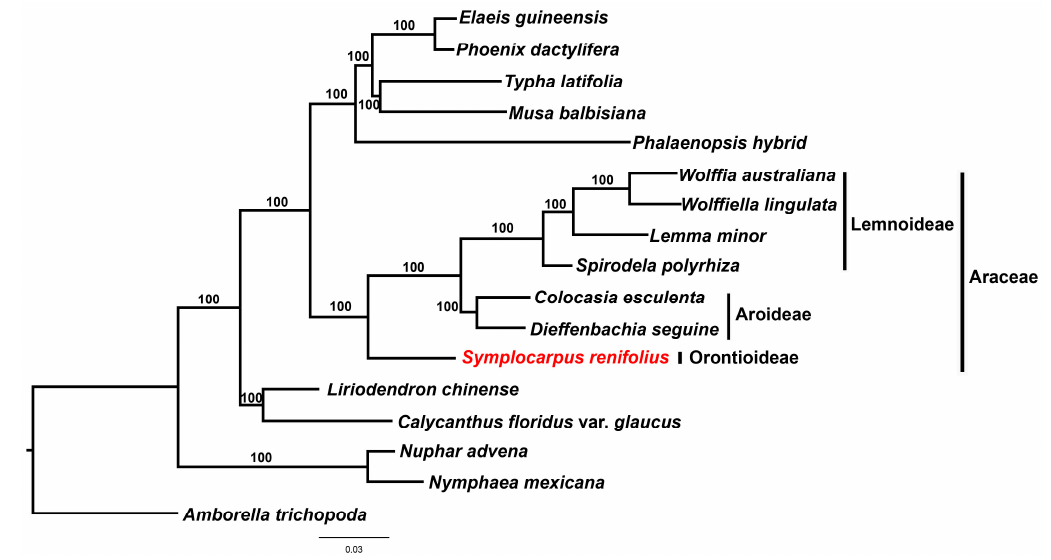
Figure 7. Phylogenetic tree reconstruction of 17 taxa using maximum likelihood method based on concatenated sequences of 77 protein-coding genes. Bootstrap support values >50% are given at the nodes.